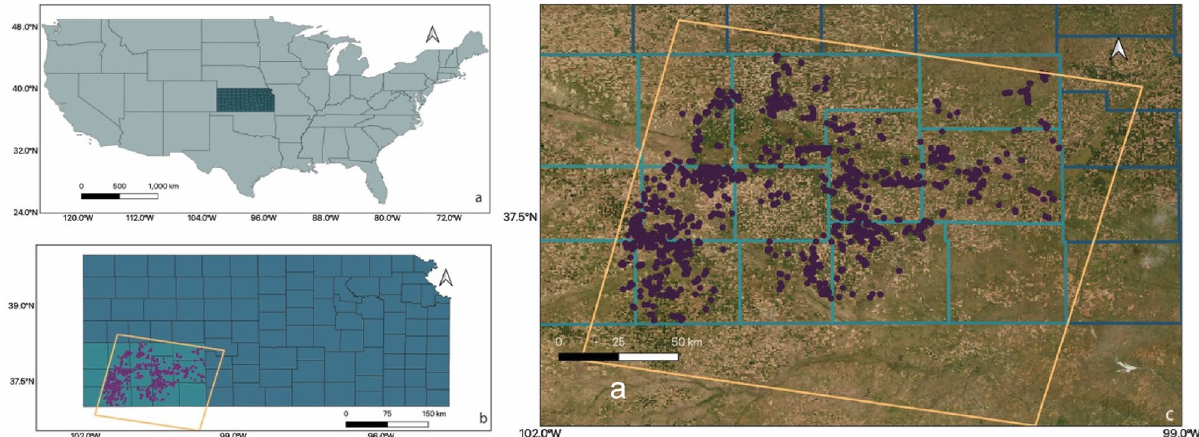
Figure 1. ( a ) area of study highlighting, the USA, in green and Kansas in blue ( b ) Area of study. The purple points correspond to phenology measurements in Kansas’s Southwest Agricultural District; the orange area corresponds to Landsat 8 tile 30/34, which covers the area under study. ( c ) Zoomed-in highlight of the Southwest Agricultural District (light blue area) and the location of each phenology measurement. Maps were created using ArcGIS software version 10.7 by Esri. ArcGIS and ArcMap are the intellectual property of Esri and are used herein under license. Copyright Esri. All rights reserved. For more information about Esri software, please visit www. esri.